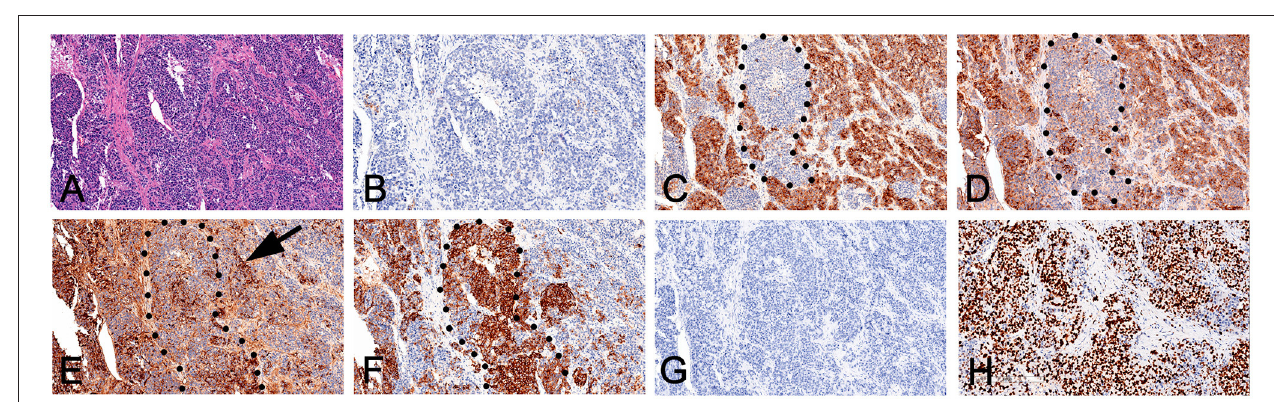
Frontiers in Surgery |